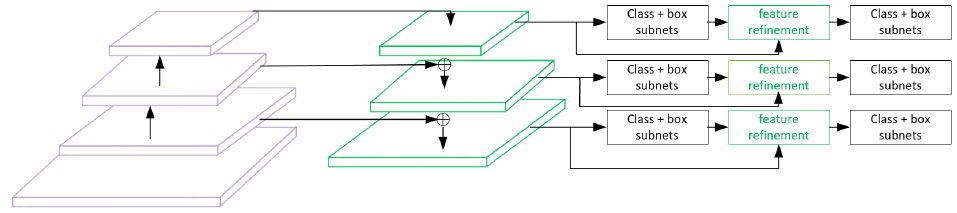
Figure 13. The network architecture of R3Det.